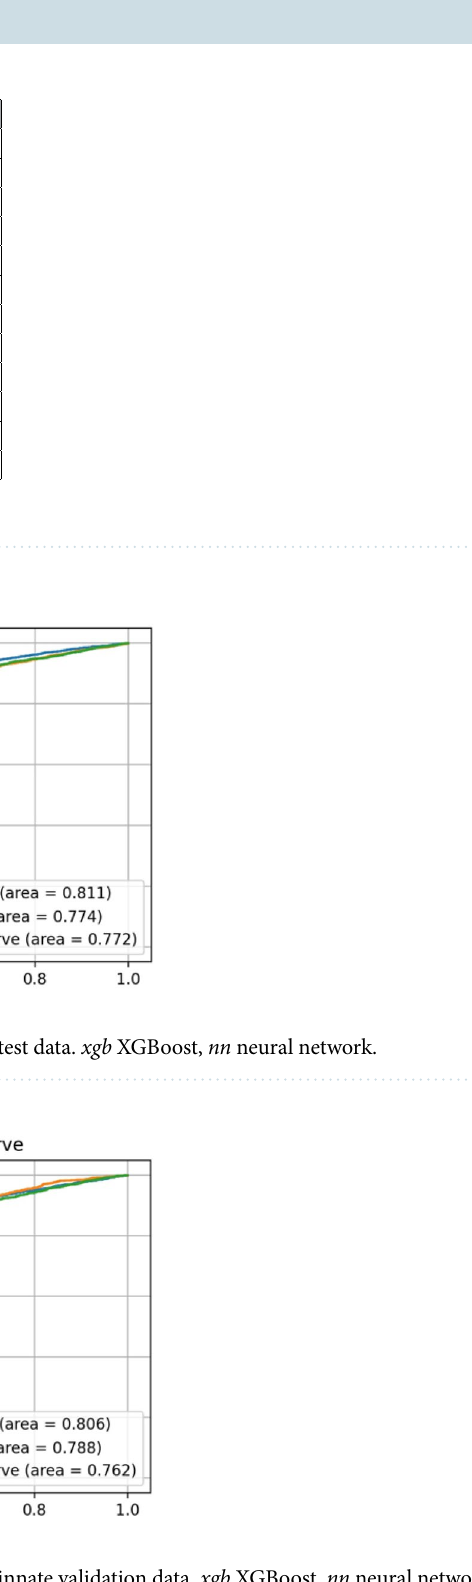
Figure 2. Predictive ability of the model using innate validation data. xgb XGBoost, nn neural